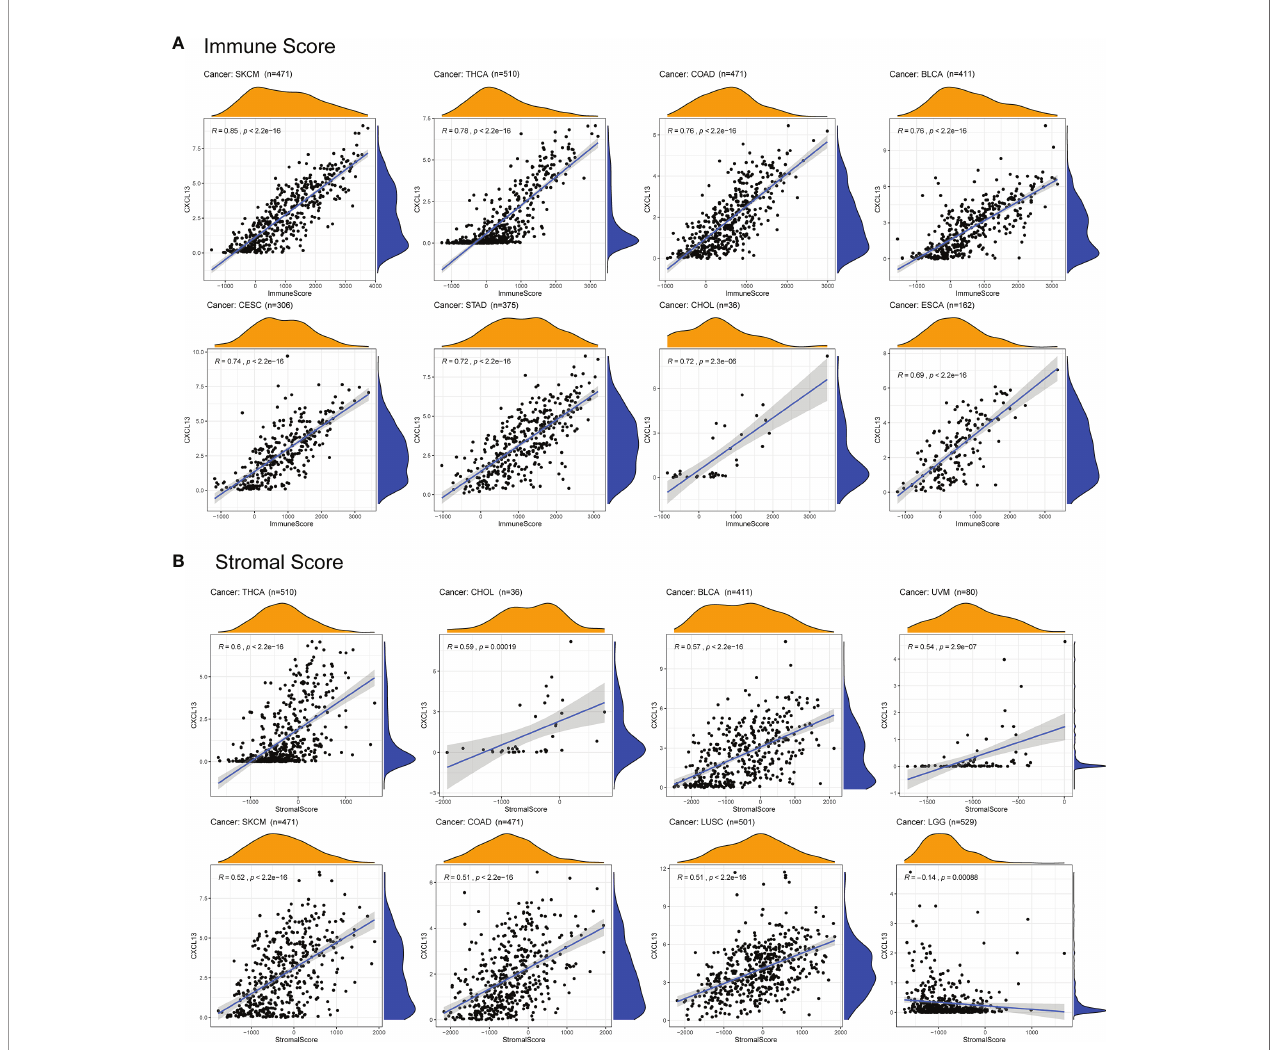
FIGURE 7 | Correlation between CXCL13 expression and immune scores and stromal scores by ESTIMATE algorithm. (A) The top eight tumors most strongly associated with the immune scores. (B) The top eight tumors most strongly associated with the stromal